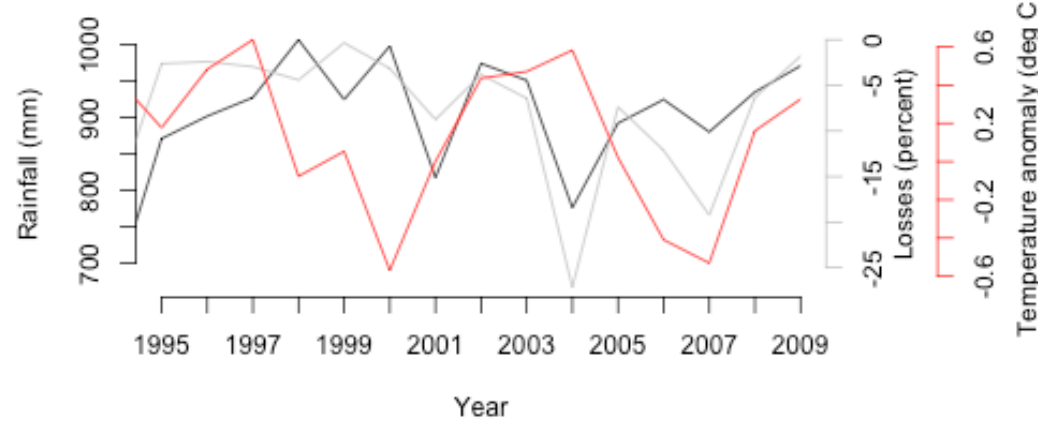
Figure 1. Time series of total November-March rainfall (black), temperature anomaly (red) and mean yield losses (grey) at the 38 locations shown in Figure 2.